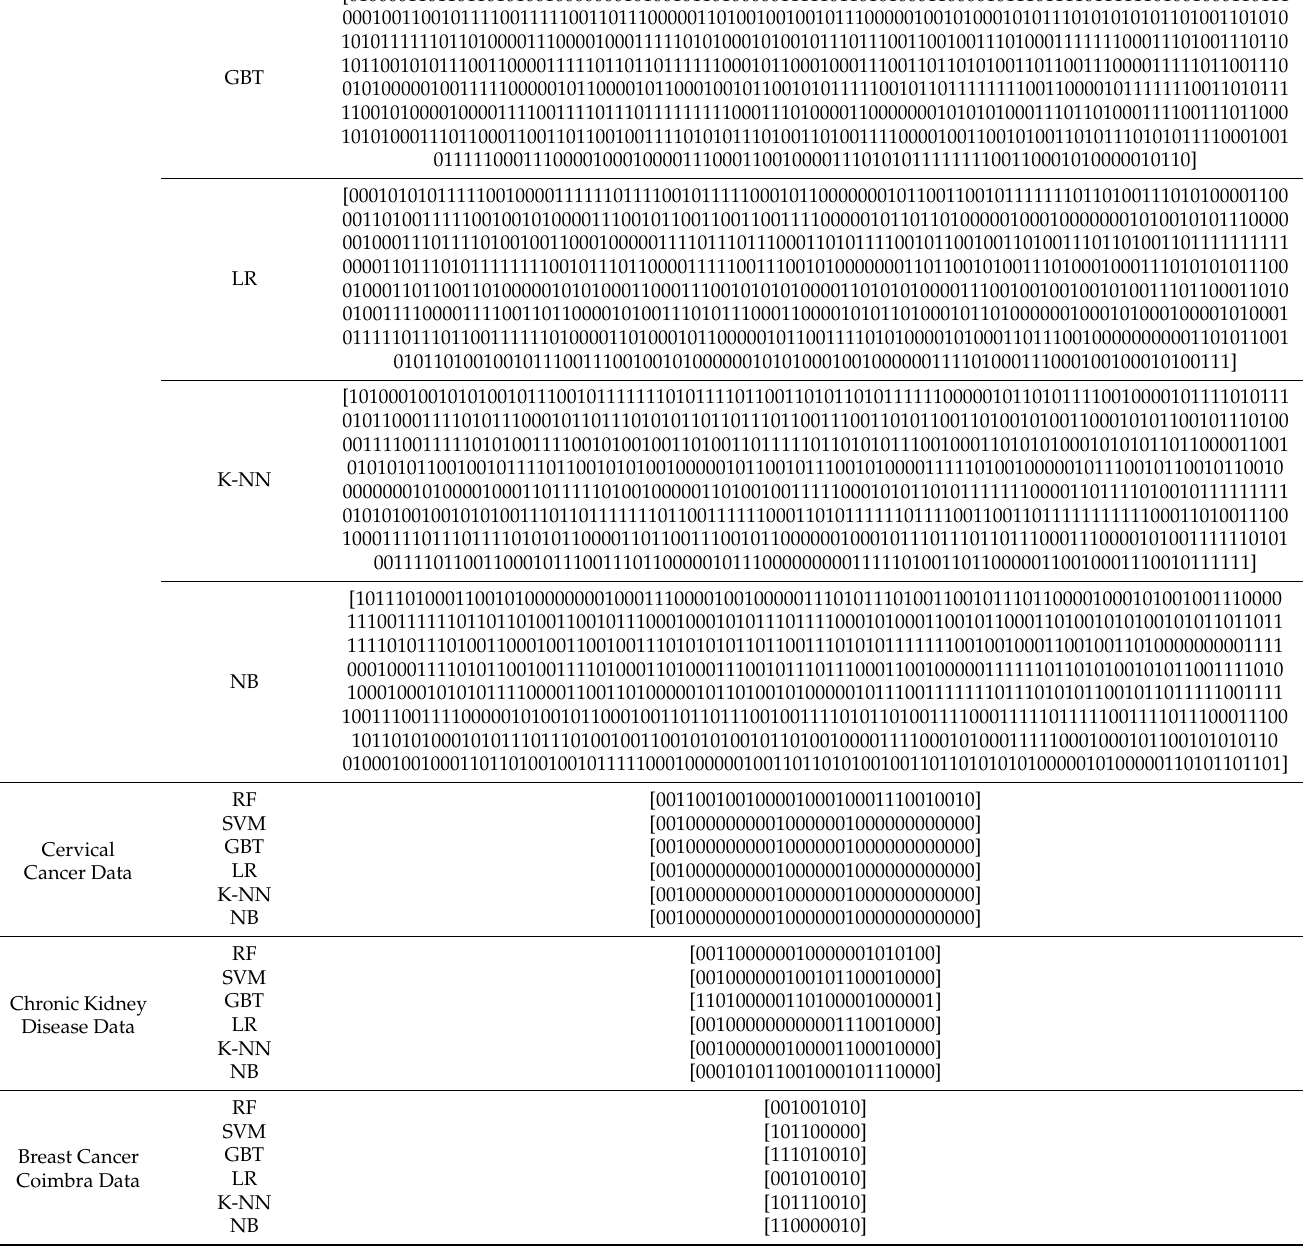
Table 13. BPSO GBest Values Results